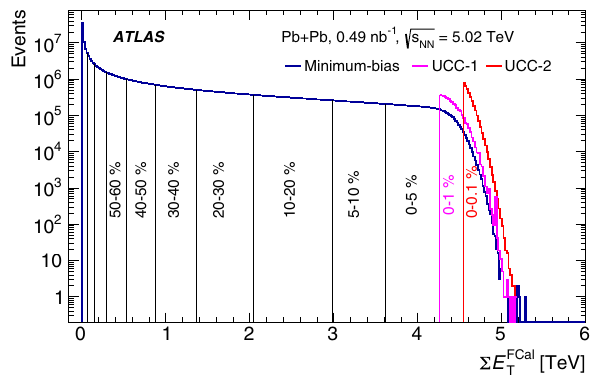
√ Fig. 1 The (cid:8) E FCal s distribution in = 5.02 TeV Pb+Pb data for T NN thresholdsfor eventsselectedbytheminimum-biastrigger.The (cid:8) E FCal T several centrality intervals are marked with vertical lines and labelled on the plot. Also shown are the number of events over the 0–1% and 0–0.1% centrality intervals selected by the ultra-central triggers